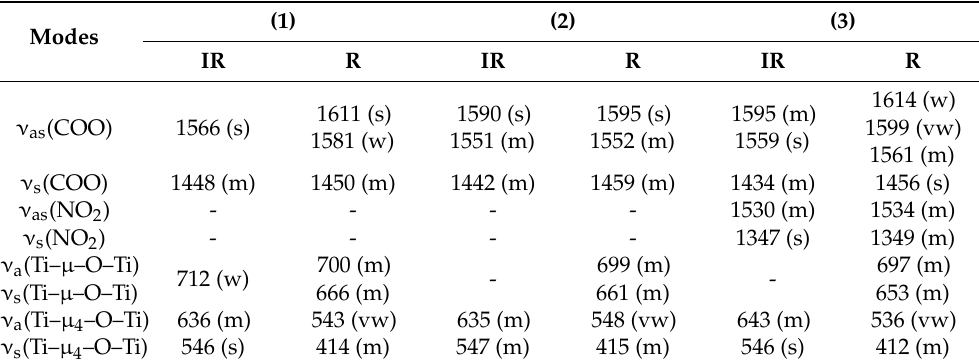
Table 3. Results of vibrational spectra studies of ( 1 )–( 3 ) complexes.